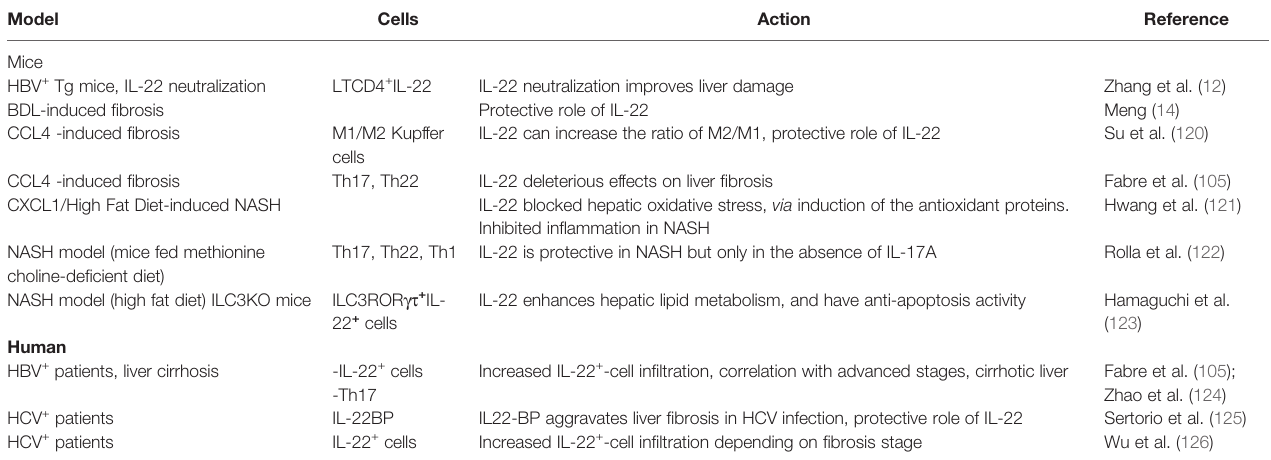
TABLE 4 | IL-22 in chronic liver